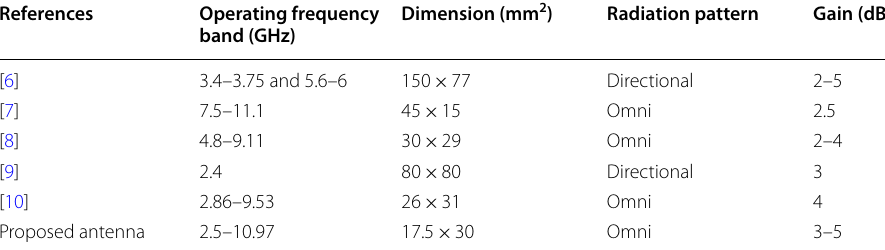
Table 1 Comparison of proposed antenna with existing antenna